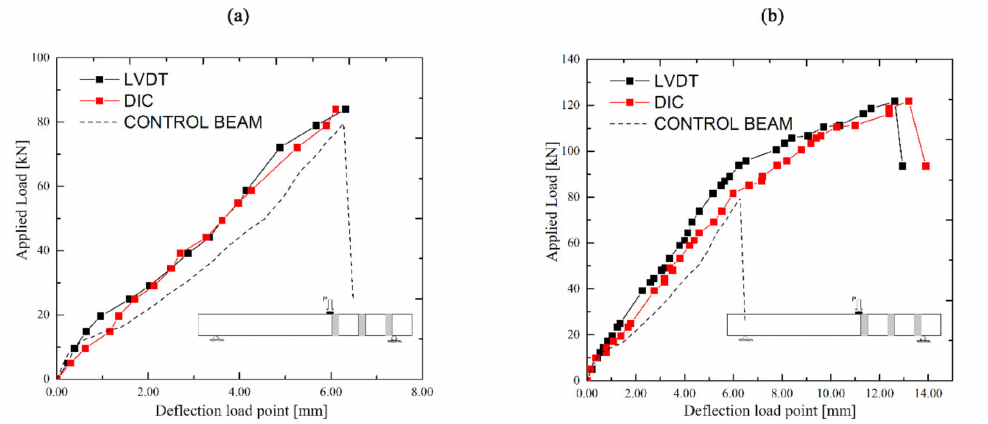
Figure 5. ( a ) B-D-1L-3S: comparison in terms of load-deflection curves; ( b ) B-D-2L-3S: comparison in terms of load-deflection curves.